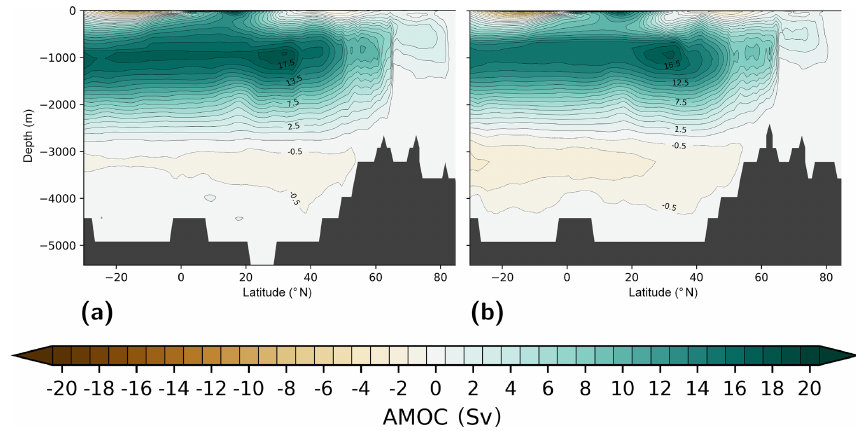
Figure 17. Atlantic Ocean Meridional Overturning Circulation (AMOC) in Sverdrups (1Sv ≡ 10 6 m 3 s − 1 ) visualised via the basin-wide zonal- and time-integrated stream function. Shown are (a) E600 and (b) Eoi400_GW. Positive AMOC values illustrate clockwise circulation from the viewpoint of Europe and Africa. Dark grey shading illustrates bottom topography zonally averaged across the basin.